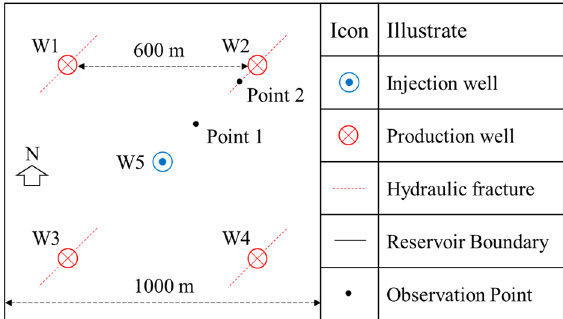
Figure 5. Schematic of fracturing flooding well group.